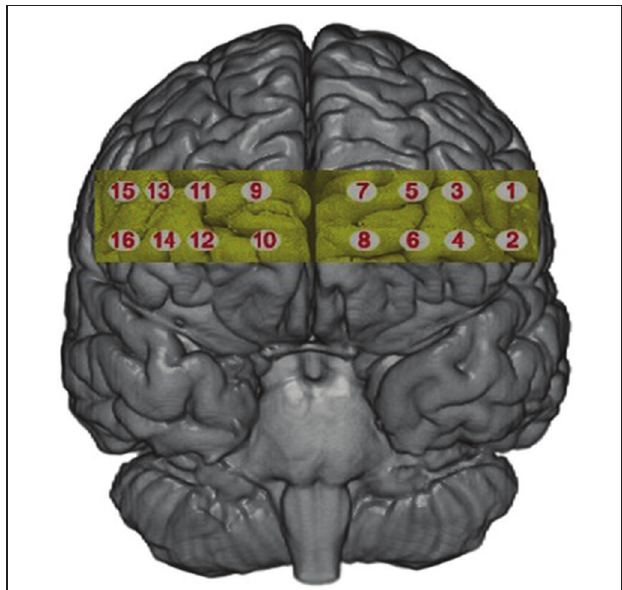
FIGURE 2 | The 16 voxels of the fNIRS probe located over the rPFC .